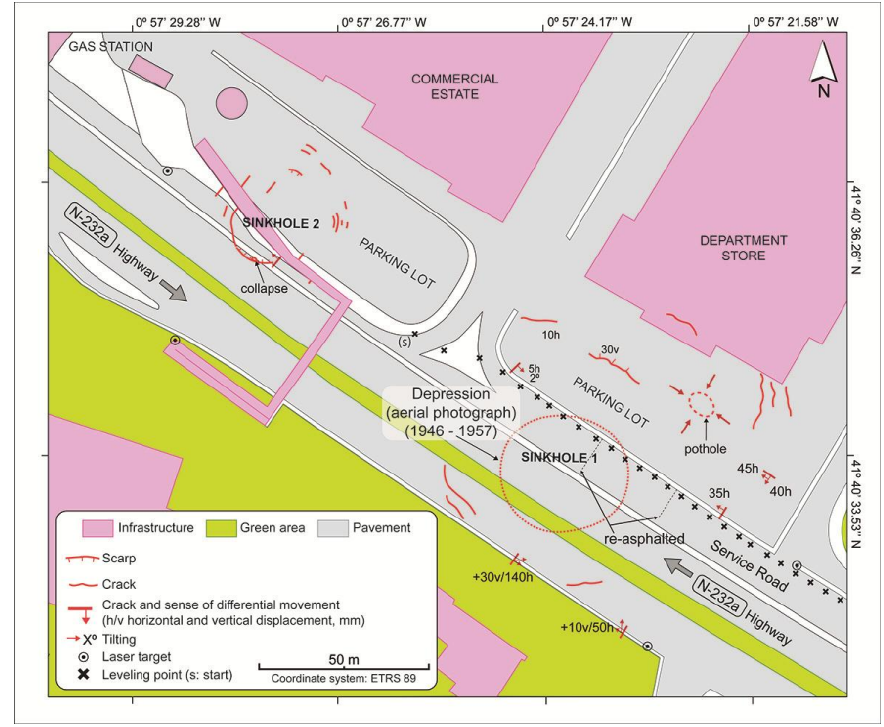
Figure 4. Map of the Logroño highway sinkholes. Surface evidence of deformation in sinkhole 1 (sinkhole in highway) and in sinkhole 2 (sinkhole in parking lot) were mapped in April 2016 and November 2011,